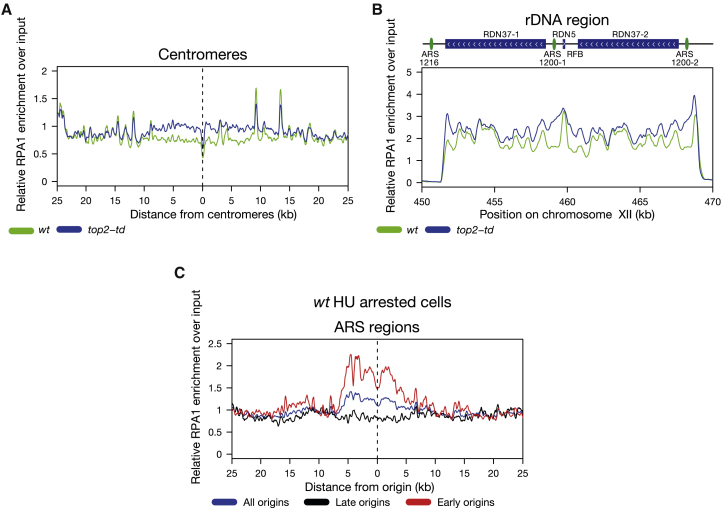
Depletion of Top2 during S Phase Causes H2AS129P Enrichment at Centromeres and over the rDNA Repeats in a Manner that Causes Accumulation of ssDNA(A) The relative enrichment of RPA1-ChIP over input around all centromeres in cells either with WT expression of Top2 in parental cells (green) or depleted of Top2 (blue) in top2-td cells, both released into the cell cycle under the restrictive conditions. Graph shown is generated from a pile up of the profiles of all centromeres and is an average of three repeats.(B) The relative enrichment of RPA1-ChIP over input across the rDNA repeats in cells either with WT expression of Top2 (green) or depleted of Top2 (blue), both released into the cell cycle under the restrictive conditions. Graph shown is an average of three repeats.(C) The relative enrichment of RPA1-ChIP over input in WT cells released into 200 mM HU under the restrictive conditions for 60 min around all origins (blue), late origins (black), and early origins (red). Origin data were used from Soriano et al. (2014). Graph shown represents one experiment.See also Figure S7.